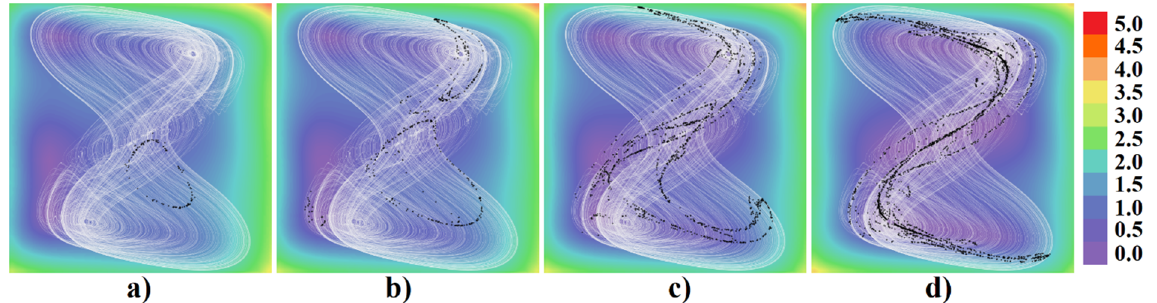
Figure 9. Distribution of kinetic energy normalized to final time 1 s over state space for chaotic attractor generated by fourth order system. Poincaré sections (black dots) are the intersections of a state trajectory (white curve) with horizontal planes defined by the following relations: ( a ) z = −0.1, ( b ) z = −0.08, ( c ) z = −0.05, ( d ) z = 0.